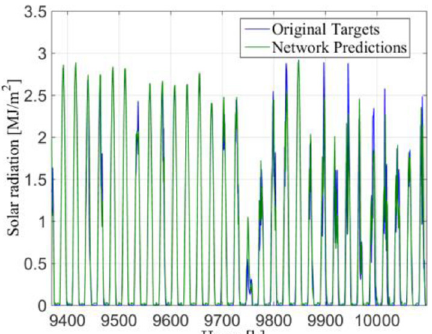
Fig. 4. Recalled hourly solar irradiation by the NARX network optimized by